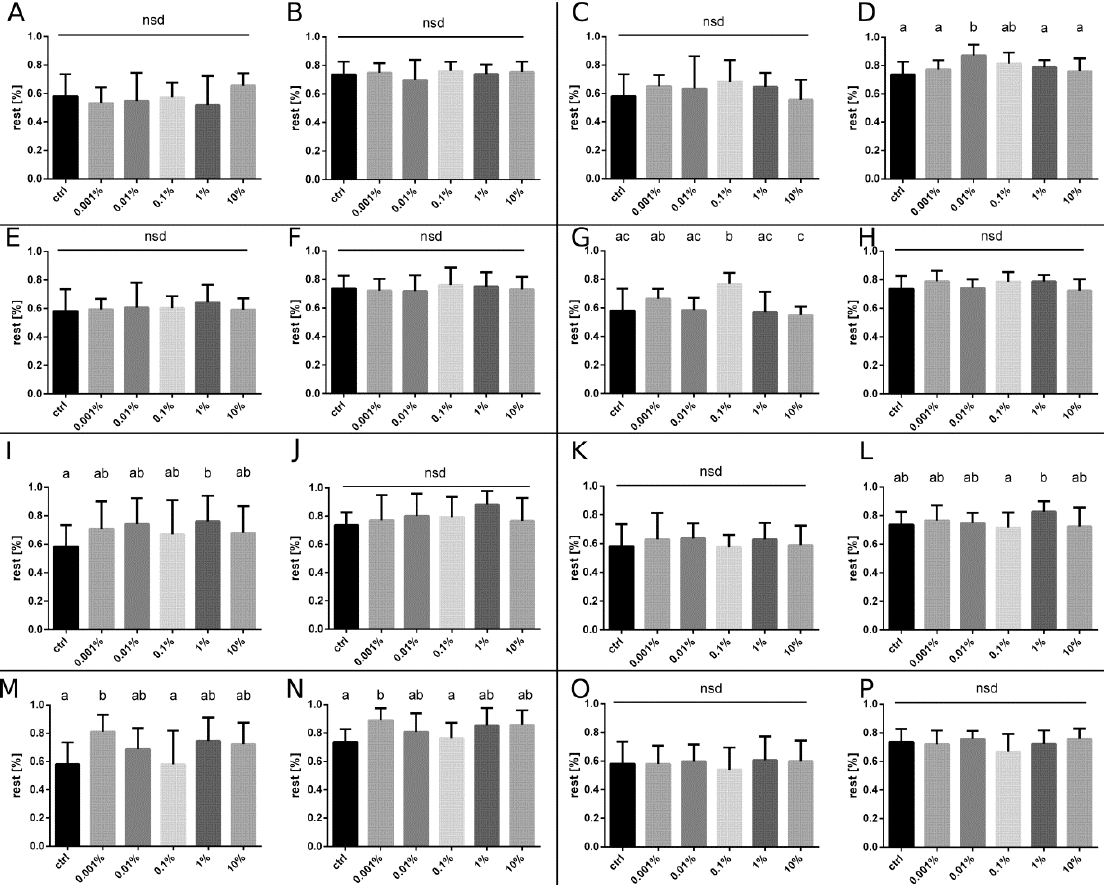
Figure 4. Resting time (%) for insects treated with a single essential oil or a mixture (1:1 or 1:1:1) of essential oils in different concentrations and the control. Median and quartiles are presented, Kruskal-Wallis test p < 0.05. Different letters indicate statistically different groups. Citronella EO ( A